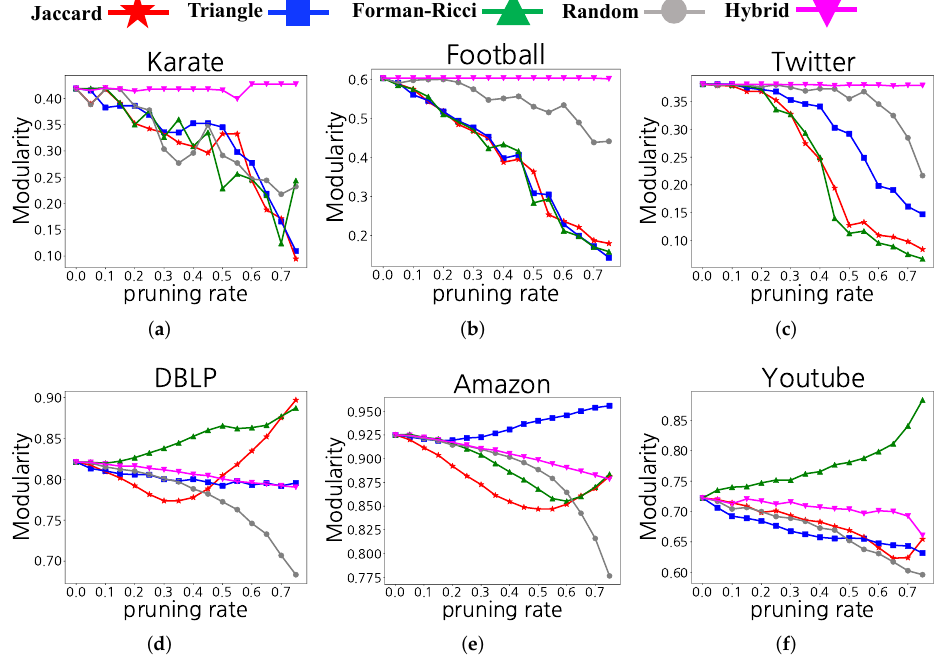
Figure 5. Modularity values when varying α : ( a ) karate; ( b ) football; ( c ) twitter; ( d ) DBLP; ( e ) Amazon; and ( f )